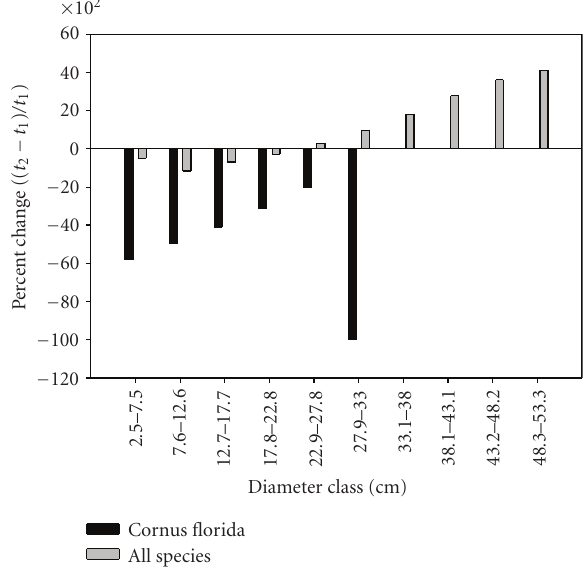
Figure 4: Total relative change of dogwood populations and populations of all species by diameter